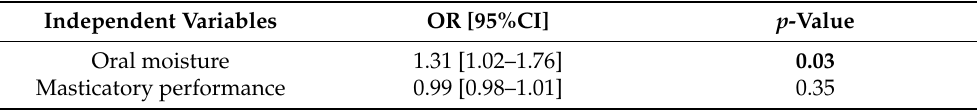
Table 2. Logistic regression analysis with the type of denture adhesive as a dependent variable. Independent